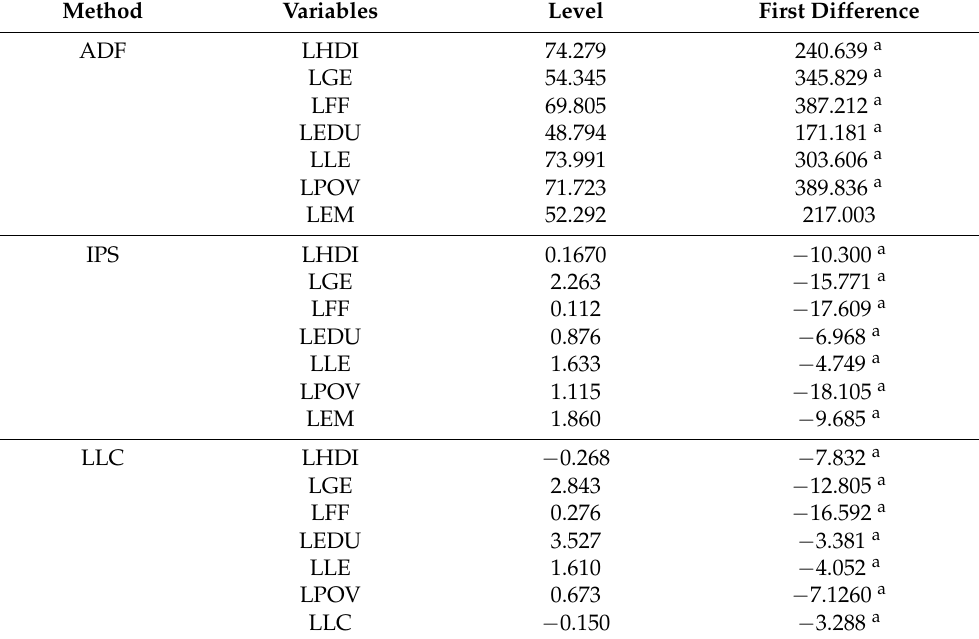
Table 5. Panel unit root test